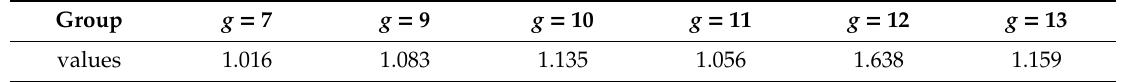
(cid:16) (cid:17) N 5,2 , ν g , g = 1, ... ,30 with absolute values greater than 1.0. k = 1